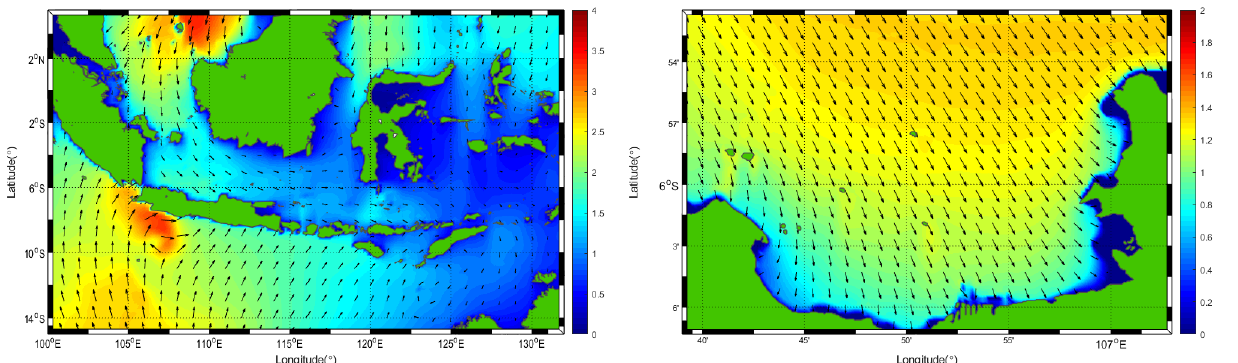
Figure 6. Snapshot of significant wave height on 6 December 2020, at 06:00 UTC, from SWAN simulation in domain I.